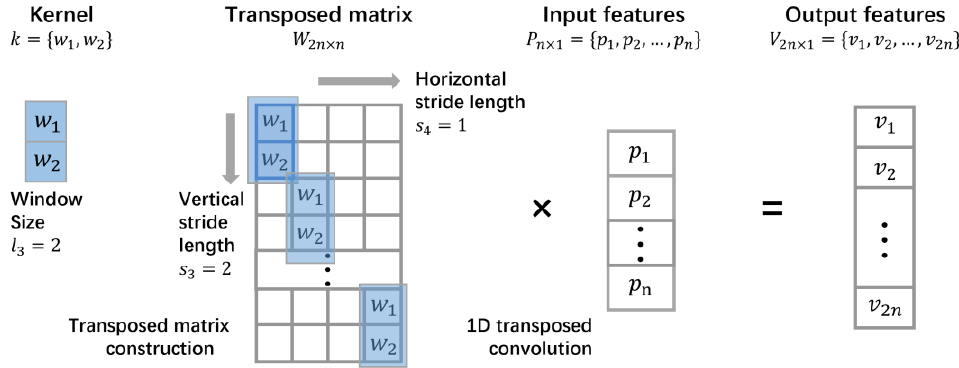
Figure 8. Illustration of the one-dimensional transposed convolution operation.